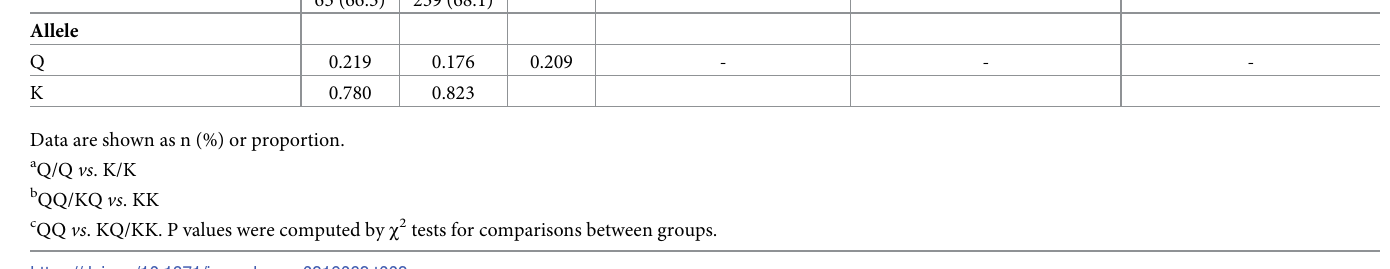
Table 2. Frequencies of the ENPP1 K121Q polymorphism between kidney transplant patients with acute rejection (AR) and without acute rejection (non-AR). ENPP1 K121Q polymorphism